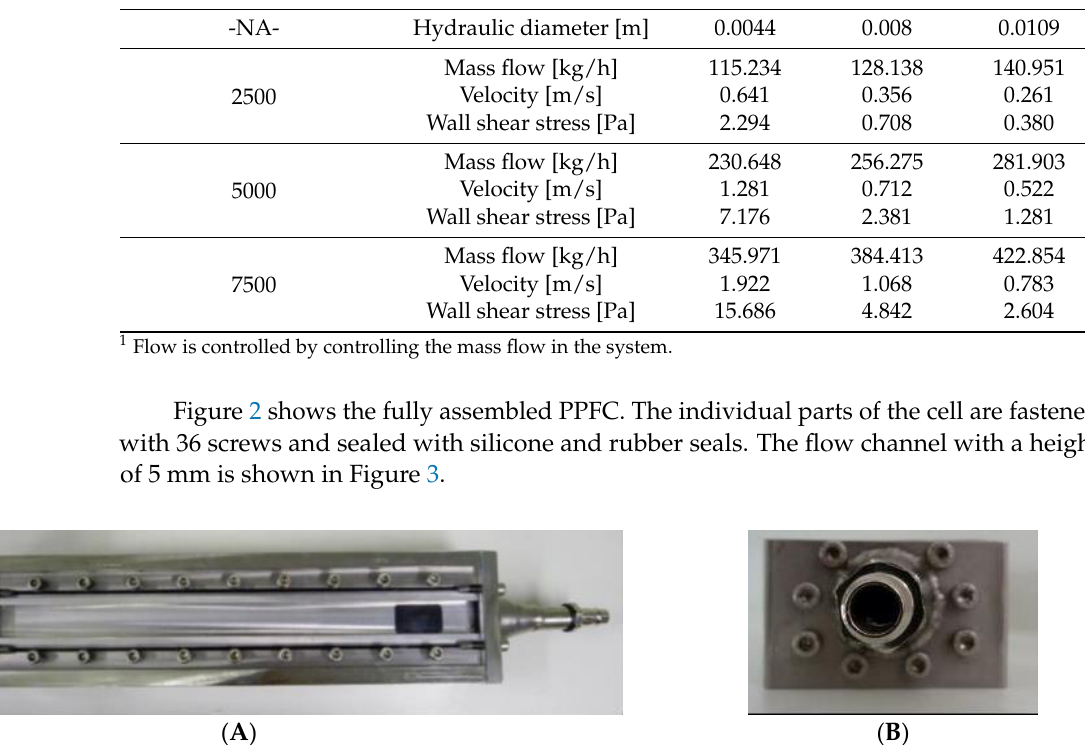
Table 1. Variation of wall shear stress and velocity under constant Reynolds number.